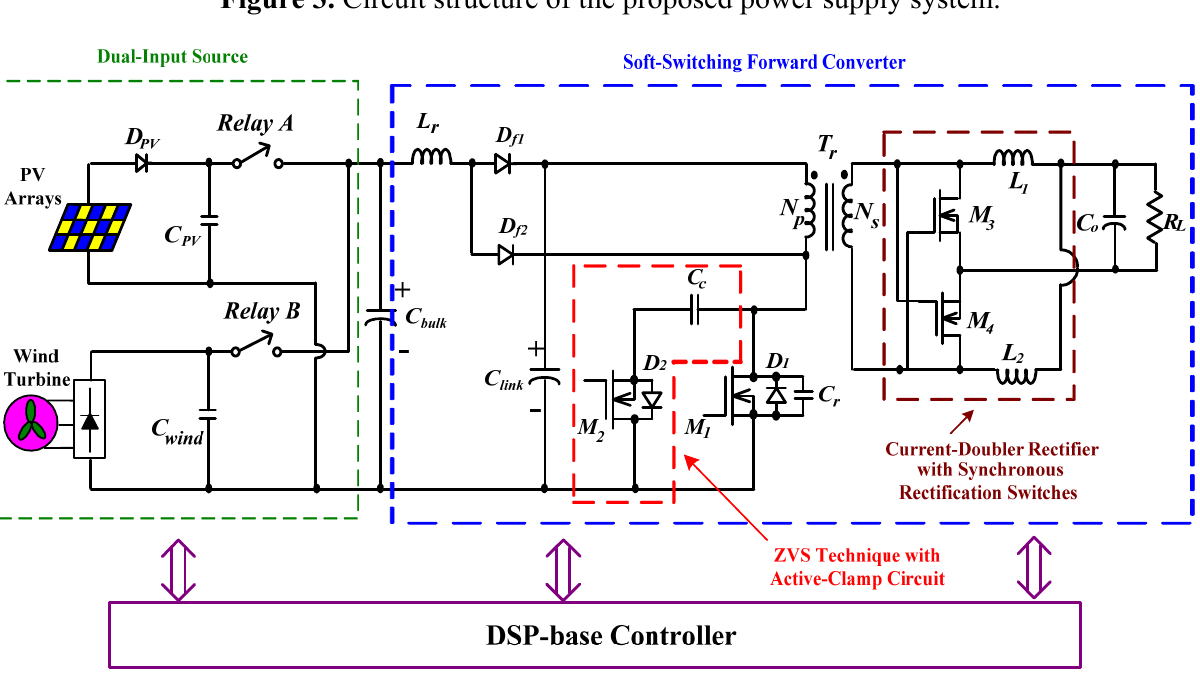
Figure 3. Circuit structure of the proposed power supply